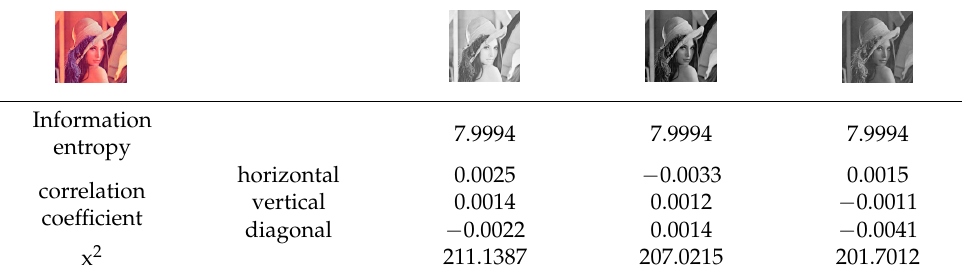
Figure 19. Correlation plot of each component before and after color lake encryption: ( a – c ) Correlation plot of R, G component, and B component of Baboon; ( d – f ) Correlation plot of R, G component, and B component of encrypted image. Table 10. Security and performance analysis of color image.